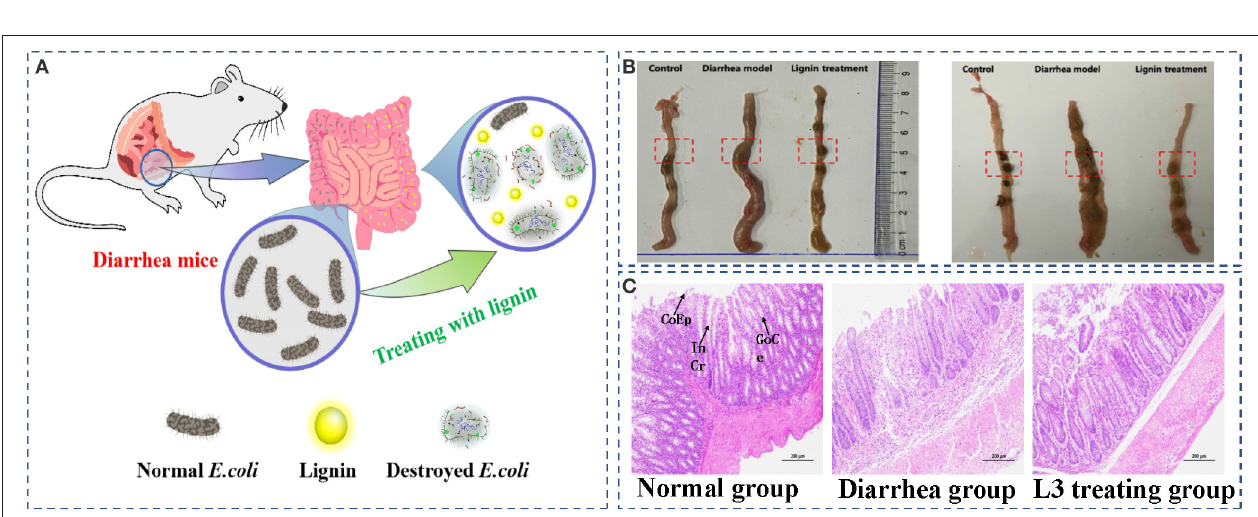
FIGURE 6 | E. coli -induced diarrhea mice infection model treated by feeding with the L3 lignin (A) ; the images of intestinal contents (B) and histopathological colon (C) of diarrhea mice before and after treatment with L3 lignin. Scale bar = 200 µ m. CoEp, columnar epithelium; InCr, intestinal crypt; GoCe, goblet cell.